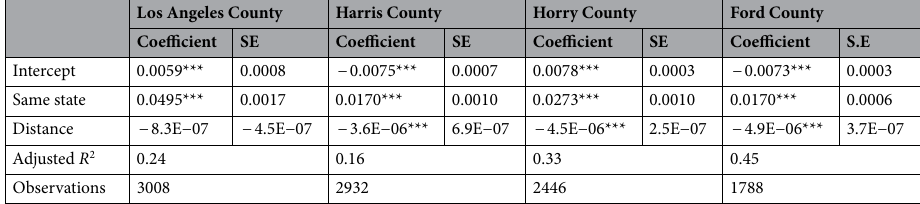
Table 1. Regression results for the four counties using the same_state as an independent variable and PCI as the dependent variable, controlling for the distance between counties. * p < 0.1, ** p < 0.05, *** p < 0.01. The county centroid was used for the distance calculation between two counties (distance unit: mile).